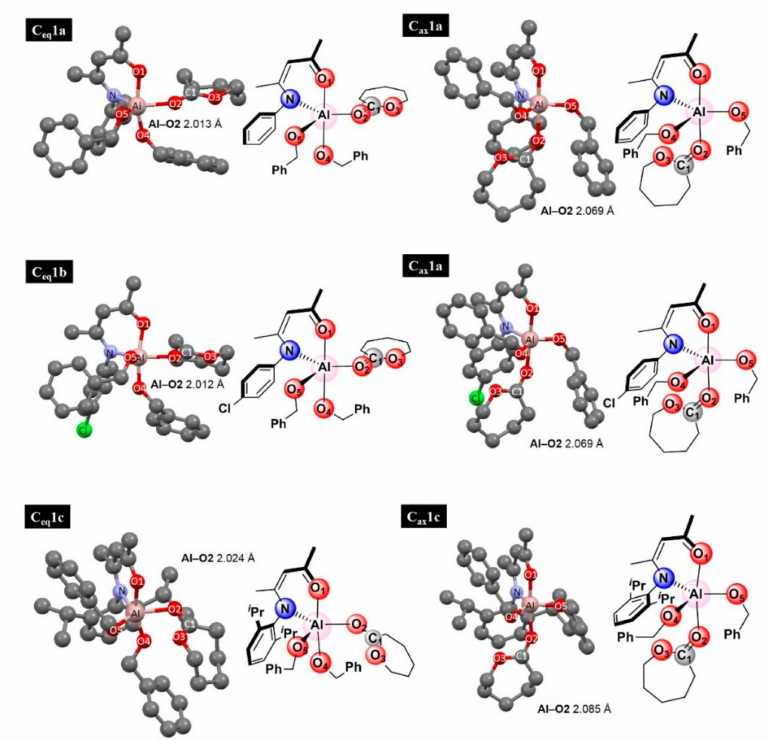
Figure 4. ε -Caprolactone coordinated aluminum complexes which bear L, L Cl , and L iPr ligand